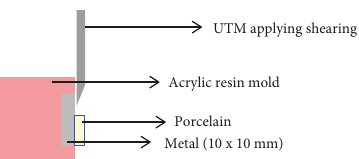
Figure 1: Shear bond strength tested using universal testing machine after fabrication of acrylic resin